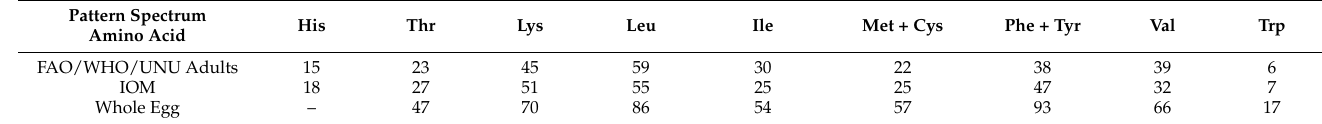
Table 1. Three spectra patterns of EAAs (mg/g protein). Pattern Spectrum Amino